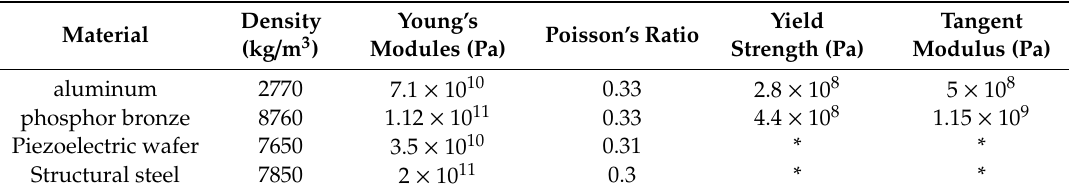
Figure 3. Bilinear isotropic hardening model. Table 2. Material parameters.